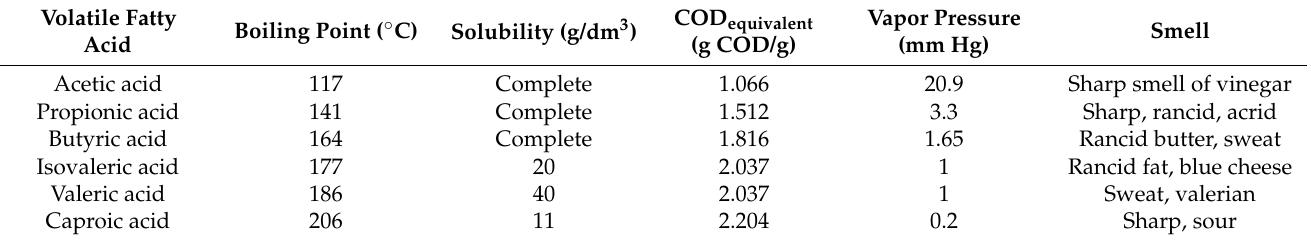
Table 1. Properties of volatile fatty acids